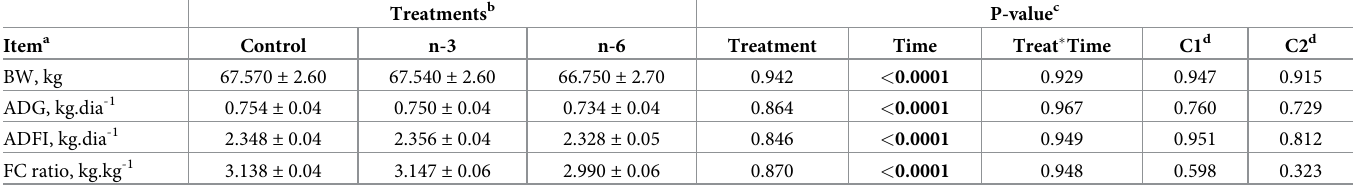
Table 3. Effect of supplementation of milk enriched with n-3 and n-6 on growth performance and feed efficiency of gilts from 34 to 190 days of age. Treatments